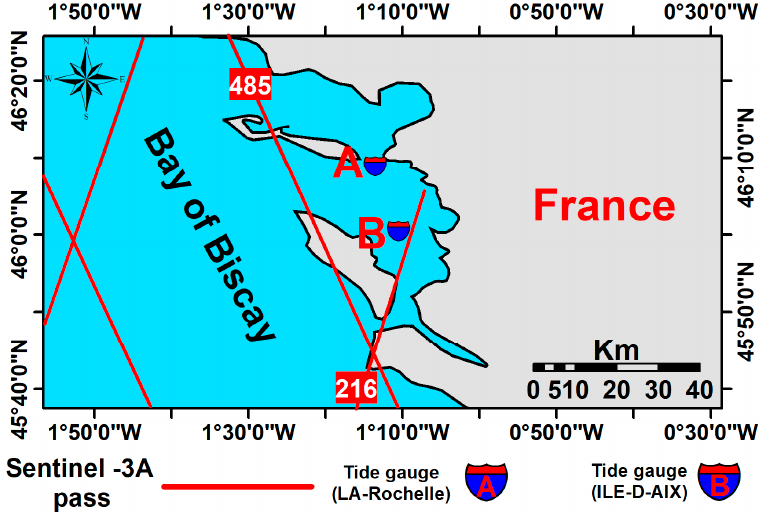
Figure 2. The location of the Sentinel-3A ground passes and tide gauge stations A (La-Rochelle) and B (ILE-D-AIX) in the Bay of Biscay.